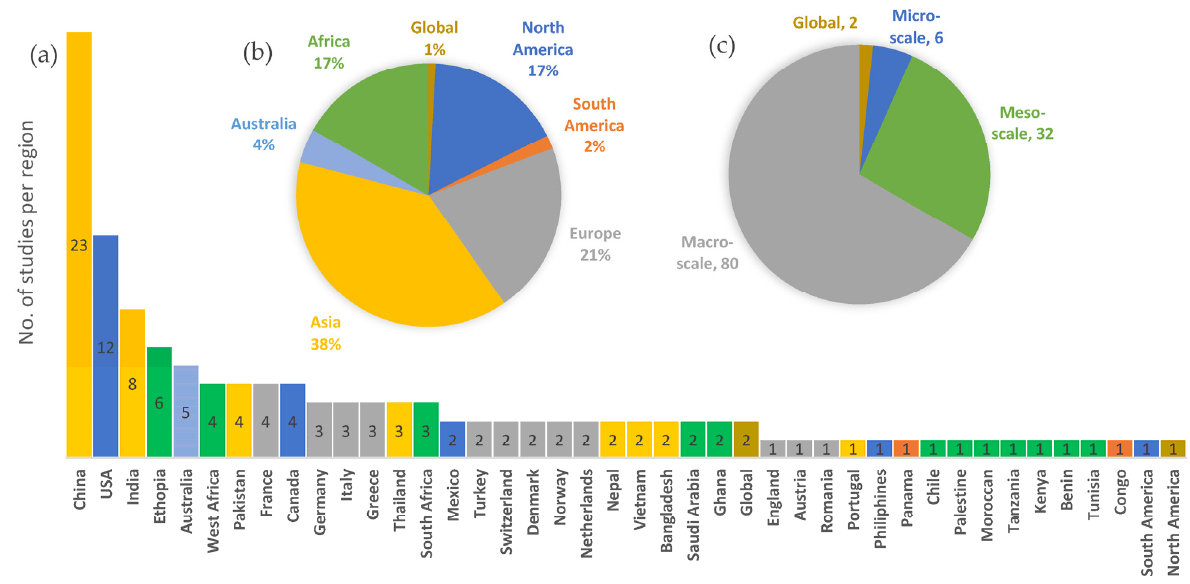
Figure 2. ( a ) Number of case study areas per country, ( b ) percentage contribution per continent, ( c ) number of studies per catchment scale.